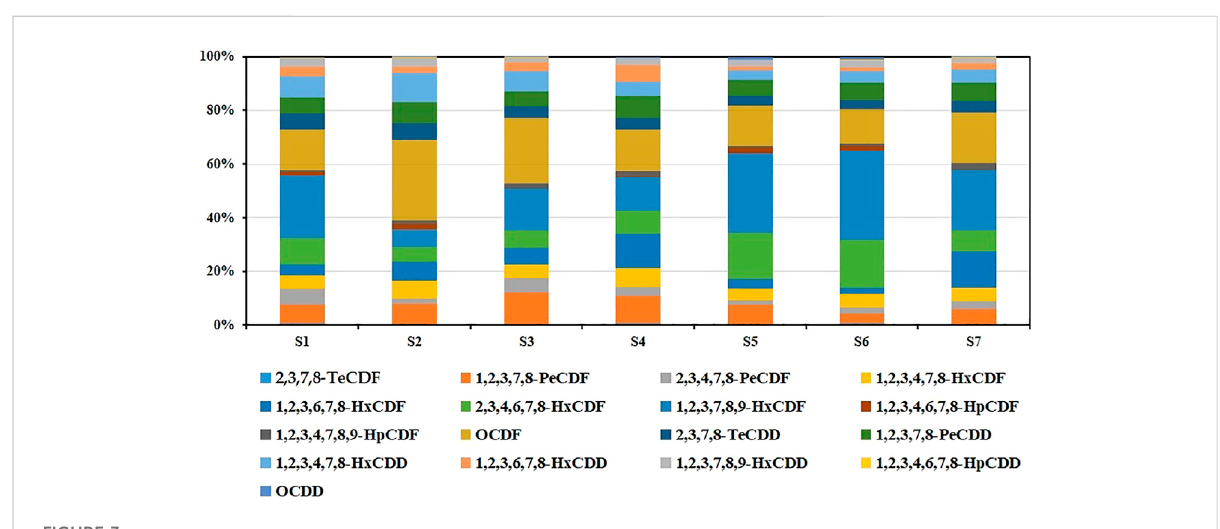
FIGURE 3 Dioxins homologs in all soil